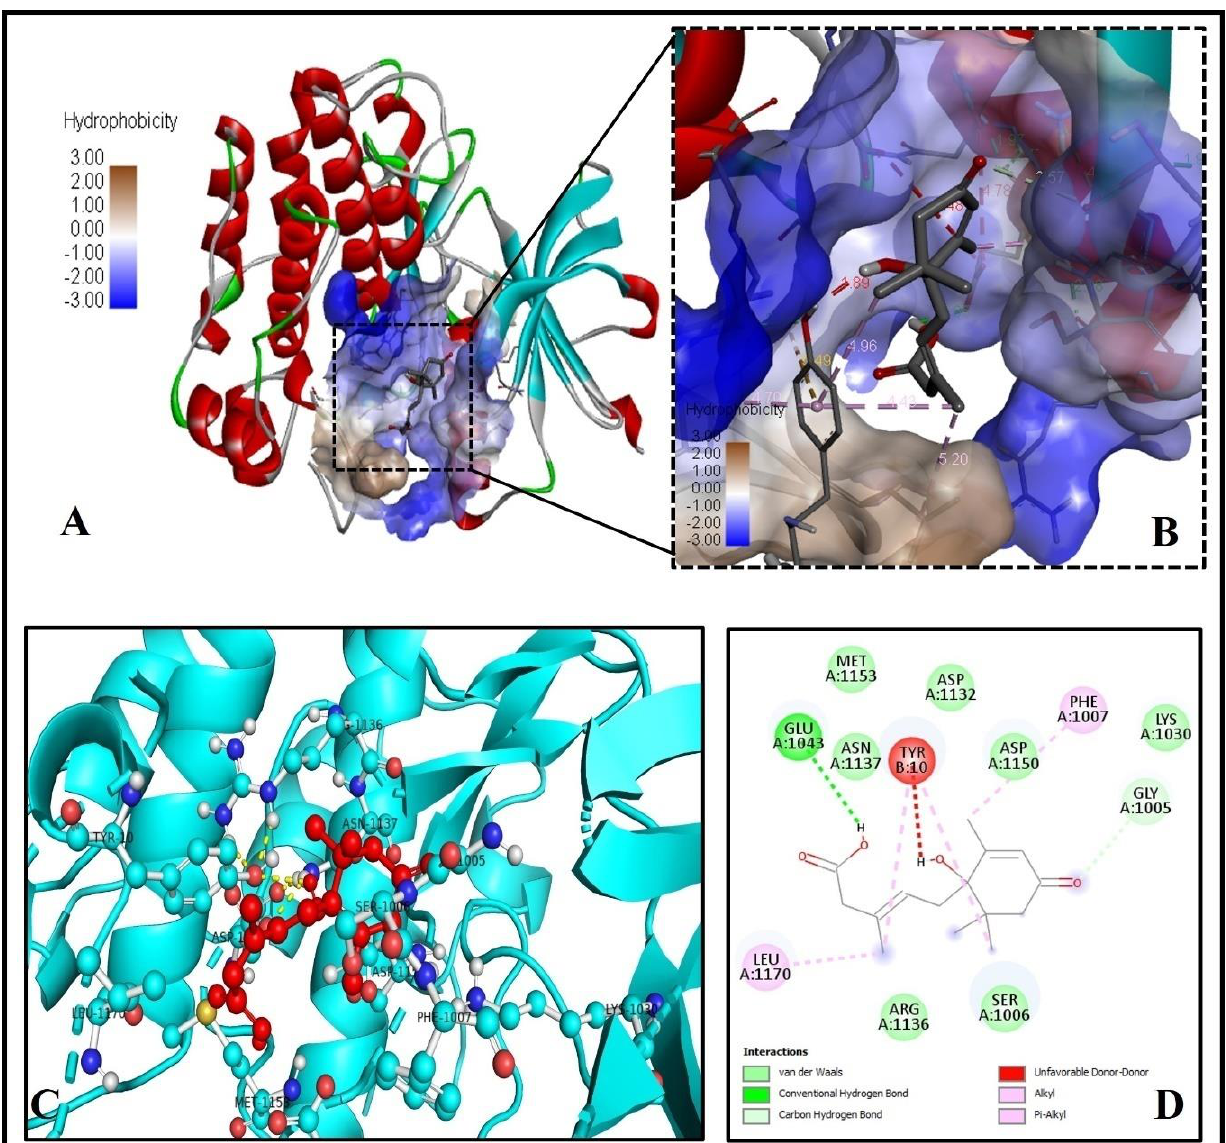
Figure 10. ABA molecular docking with human tyrosine kinase (PDB ID: 1IR3). ( A ) Binding of ABA to the active site of tyrosine kinase. ( B ) An enlarged image showing hydrophobicity of the binding cavity’s amino acid residues ( C ) The 3D picture depicts substantial interactions of ABA (red ball and sticks) with human tyrosine kinase’s essential residues (cyan ball and sticks) ( D ) The molecular level interactions of binding pocket residues with ABA are depicted in the 2D plot.